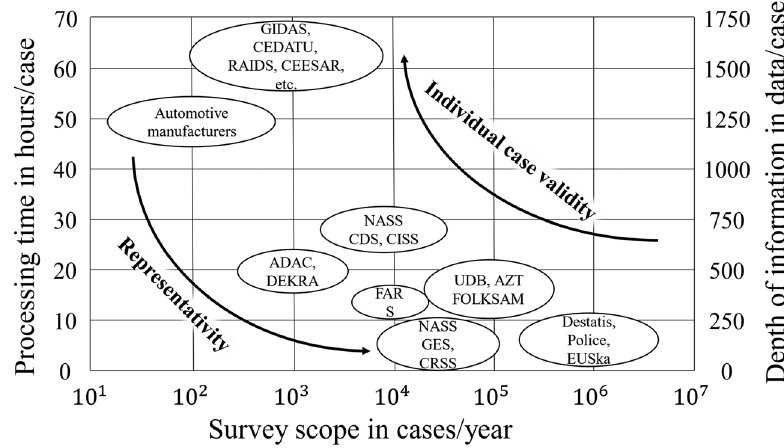
Figure 1: Scope of data collection, processing e ff ort, and depth of information in accident surveys [ 1 ]